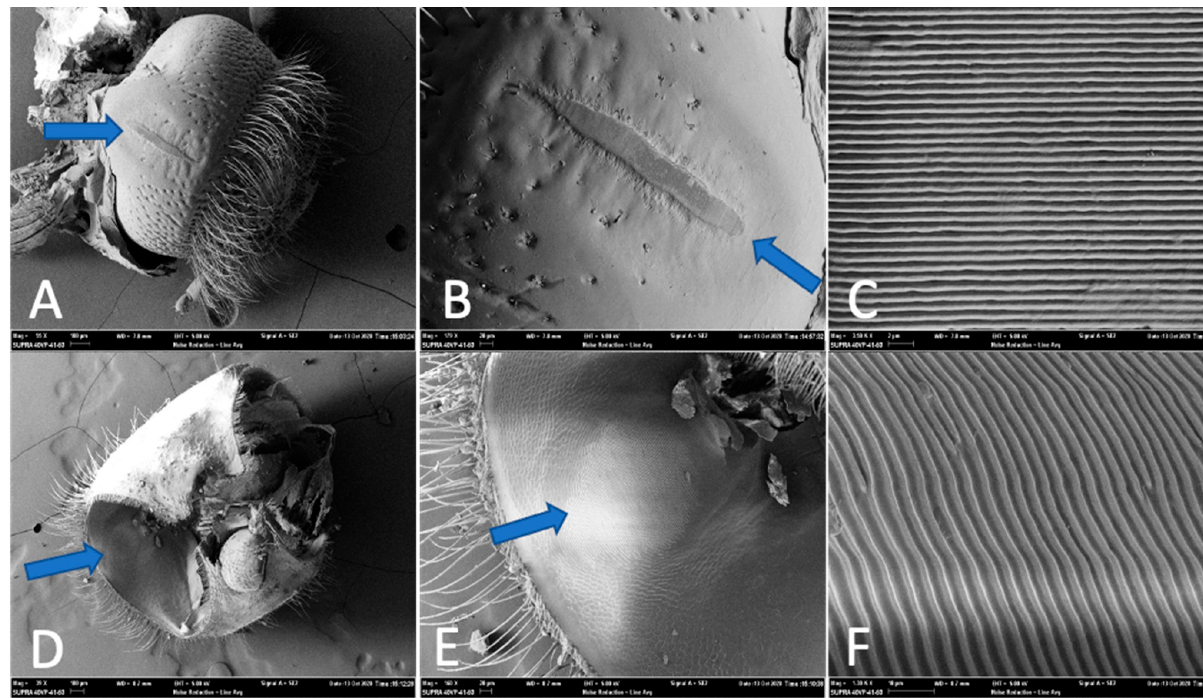
Figure 2. Scanning electron images of stridulatory structures of Ips confusus adult female. ( A ) Posterior dorsal view of head with plectrum viewed at center of image (55× magnification), ( B ) close up of entire plectrum on head (179× magnification), ( C ) ridges of plectrum on head (3500× magnification), ( D ) view of file at the anterior section of pronotum; circular and similar to a fingerprint (39× magnification), ( E ) close up of file, underside of pronotum (160× magnification), and ( F ) ridges of file on pronotum (1300× magnification).